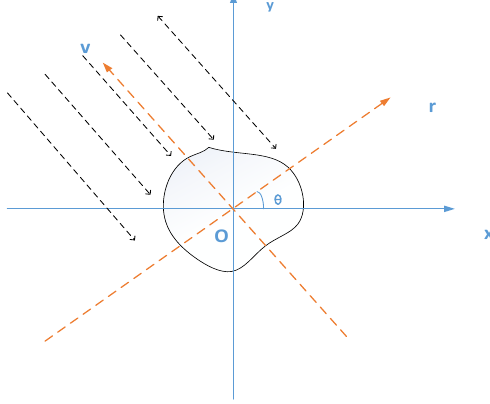
Figure 1. LRT imaging model.